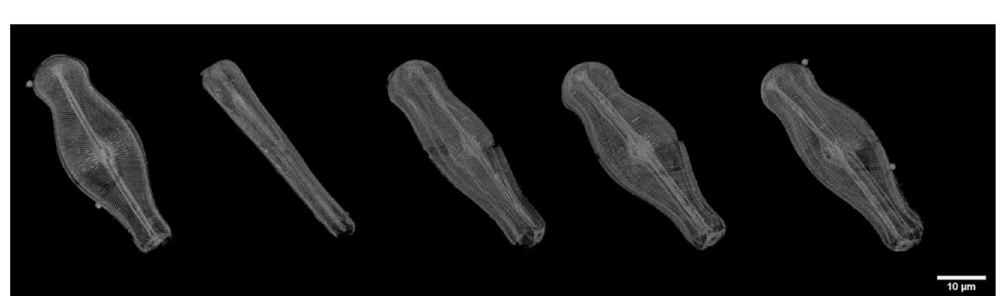
Figure 3. Three–dimensional (3D) visualization of frustule of Didymosphenia geminata based on nano-XCT